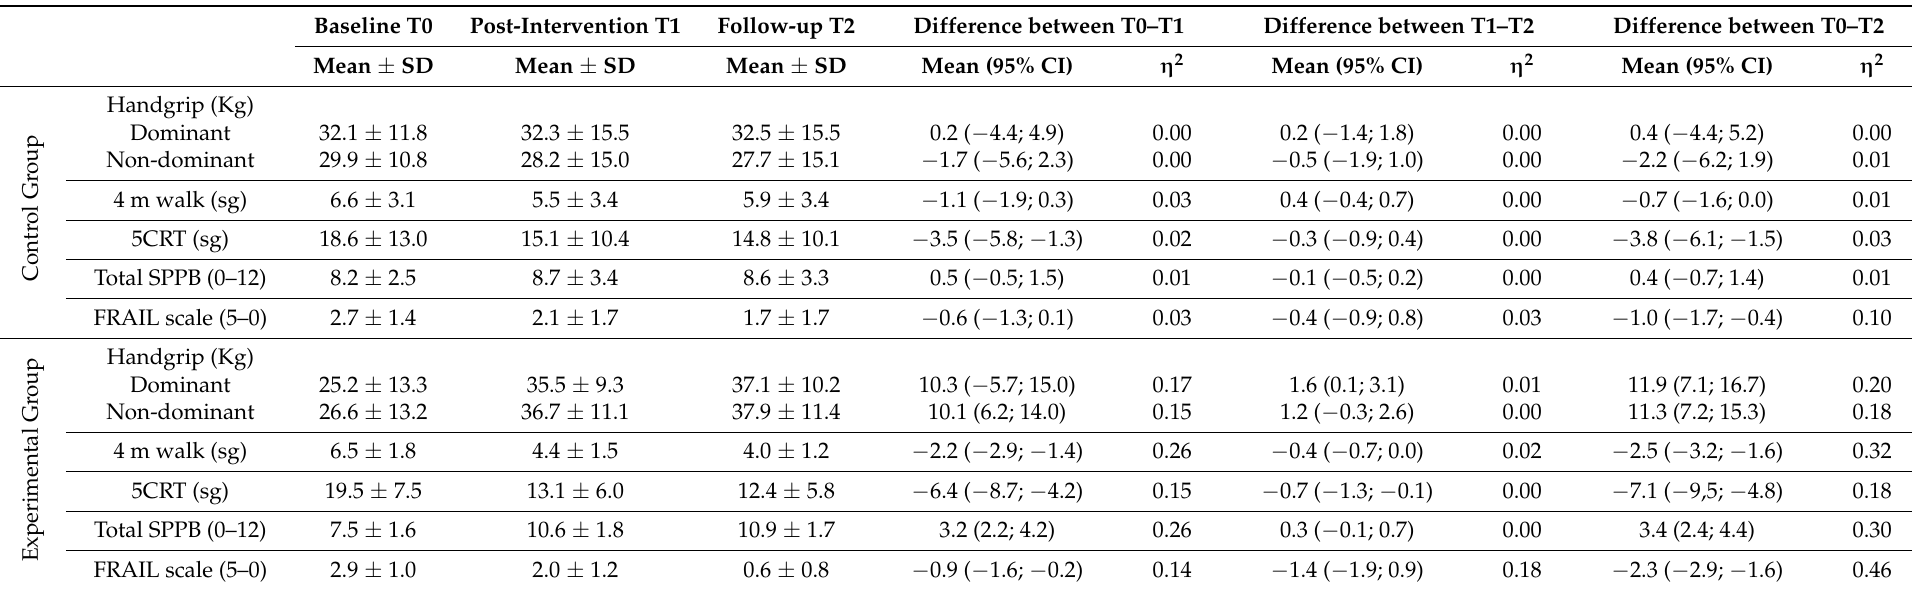
Table 2. Descriptive data and effect sizes for dependent